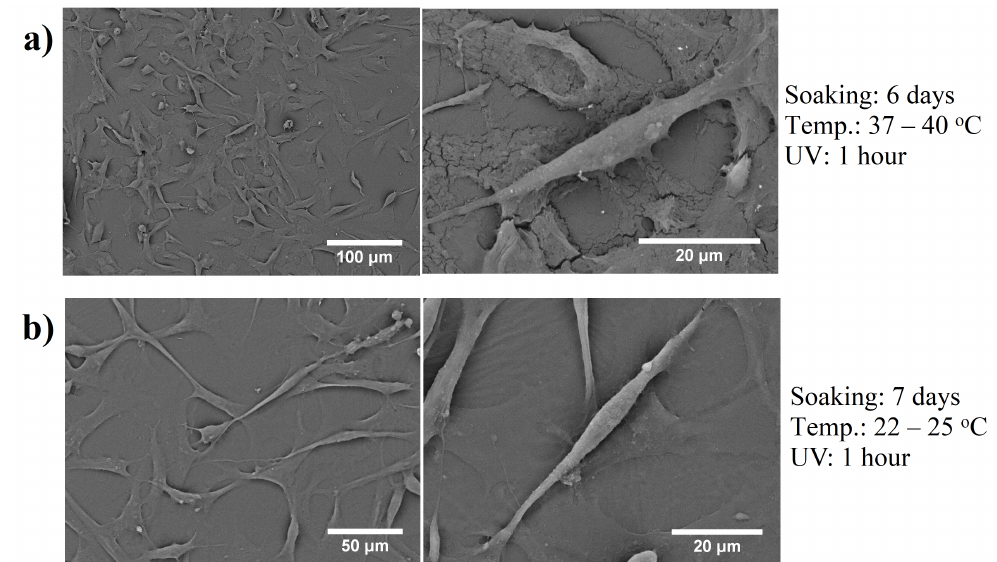
Figure 3. SEM analysis (representative images) of cells grown on different samples: ( a ) soaking duration in heated isopropanol and methanol for six days; and ( b ) soaking duration in non-heated isopropanol and methanol for seven days. Note that the sample surfaces do not influence the morphology of the